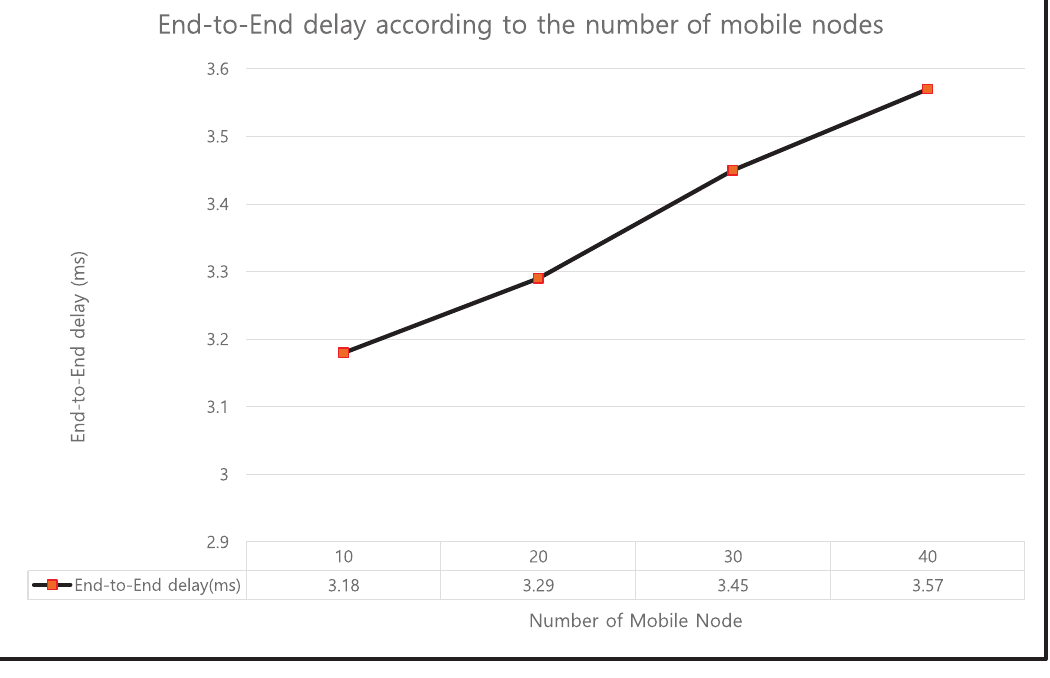
PLOS ONE | https://doi.org/10.1371/journal.pone.0247441 February 26,